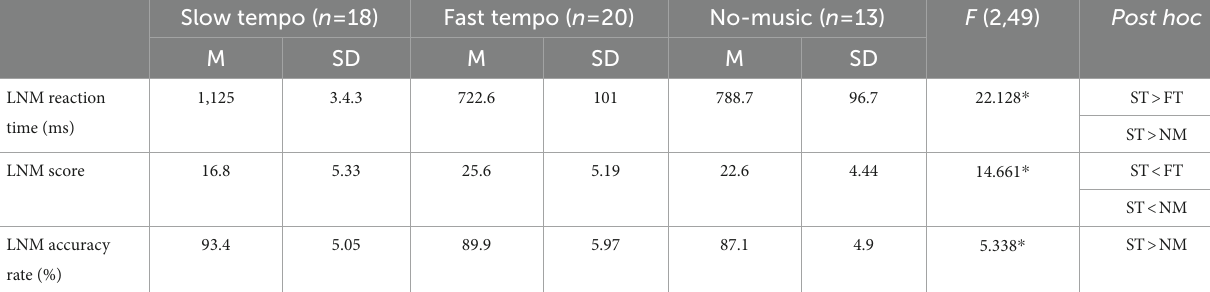
TABLE 3 Mean and standard deviation of variables in letter name matching (LNM) task.